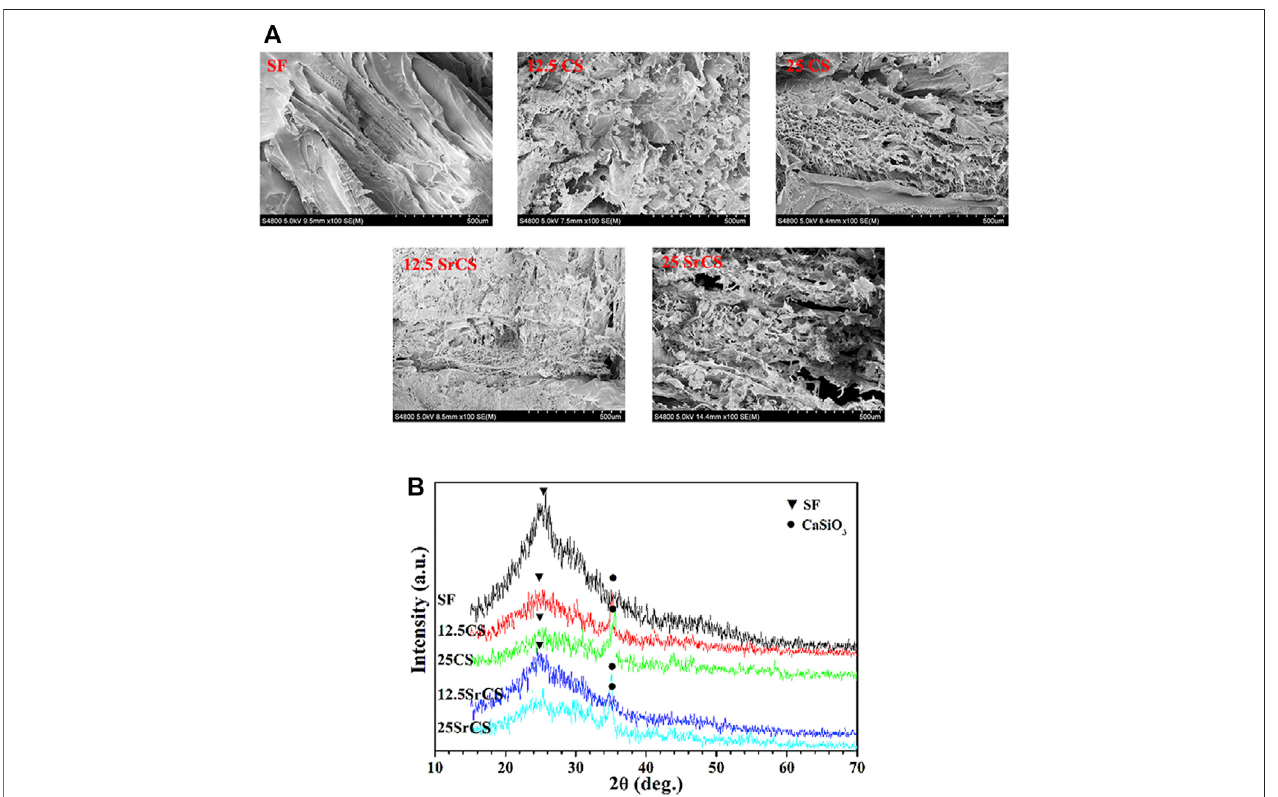
FIGURE1| Characteristicsofmaterials. (A) SEMmicrographsofmaterials(SF:SF,12.5CS:12.5 wt%CS/SF,25CS:25 wt%CS/SF,12.5SrCS:12.5 wt%SrCS/ SF, 25 SrCS: 25 wt% SrCS/SF). (B) XRD patterns of materials. (A) Scale bar = 500 μ m.